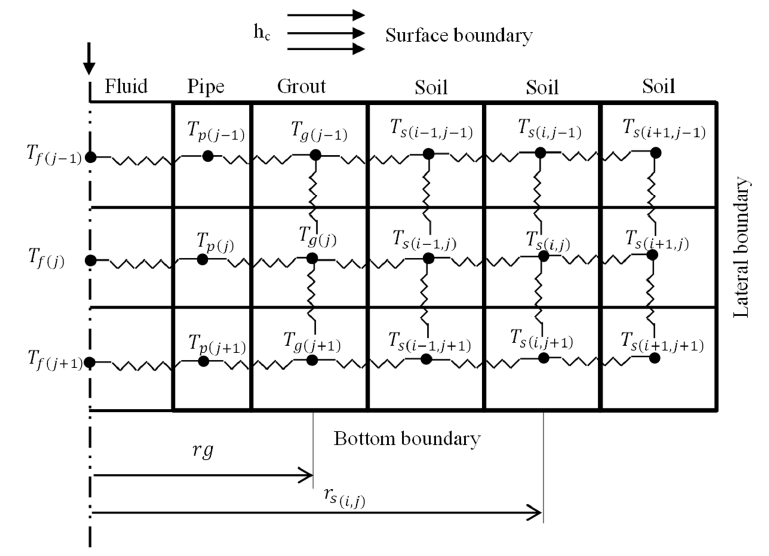
Figure 4. Computational domain of the vertical GHE.